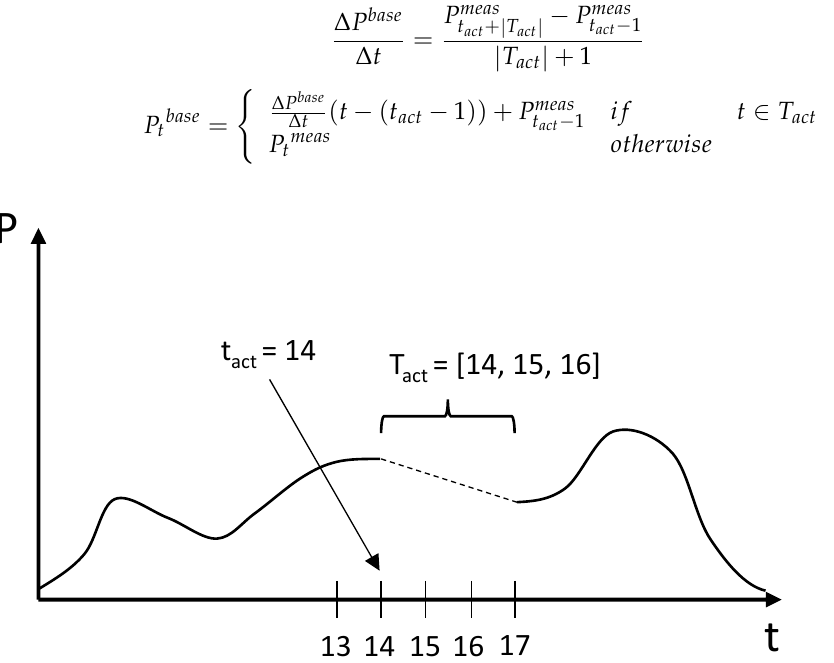
Figure 4. Illustration of baseline II and its variables. The dashed line reflects the